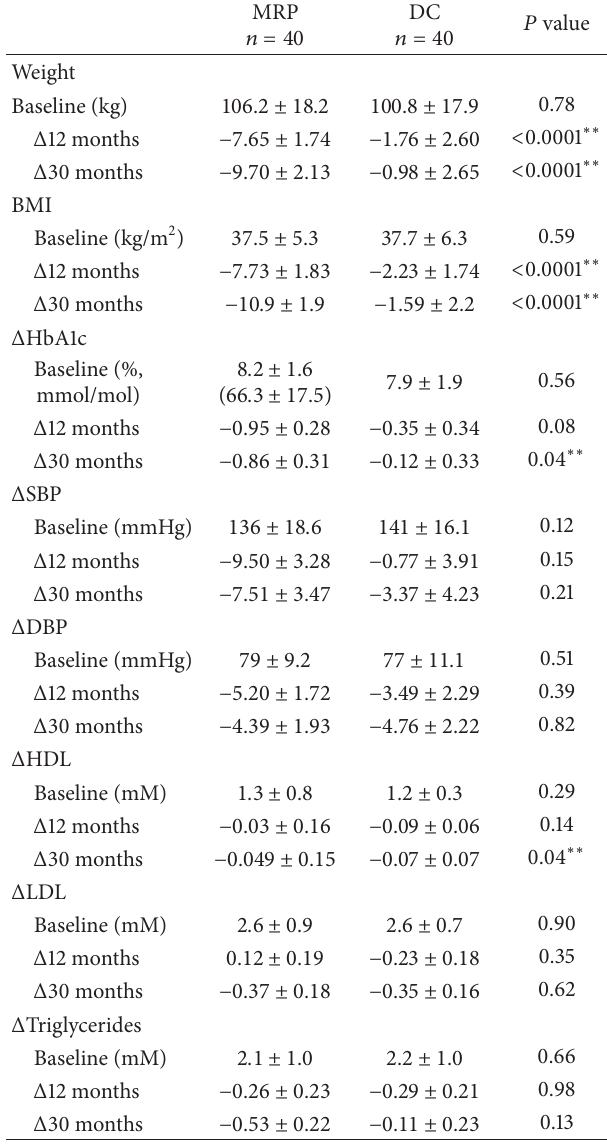
Table 2: Percent changes in weight, BMI, %HbA1c, and other clin- ical outcomes of patients enrolled in the Metabolic Rehabilitation Program (MRP) versus the diabetes clinic (DC) at 12 and 30